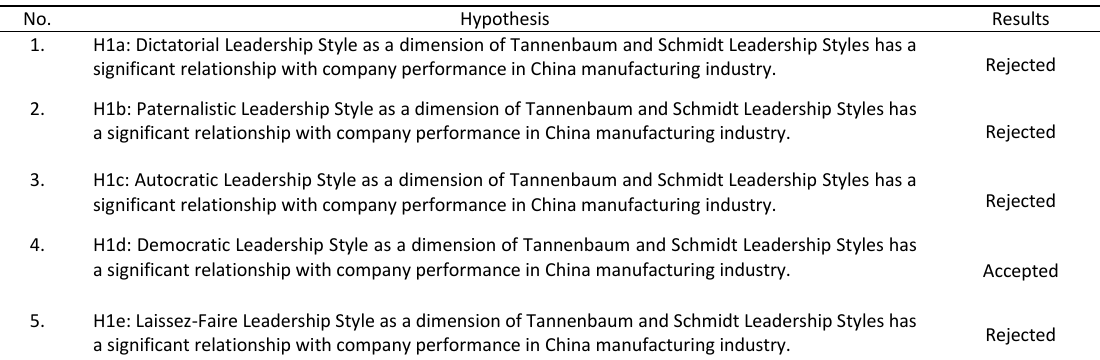
Table 4. Summary of Research